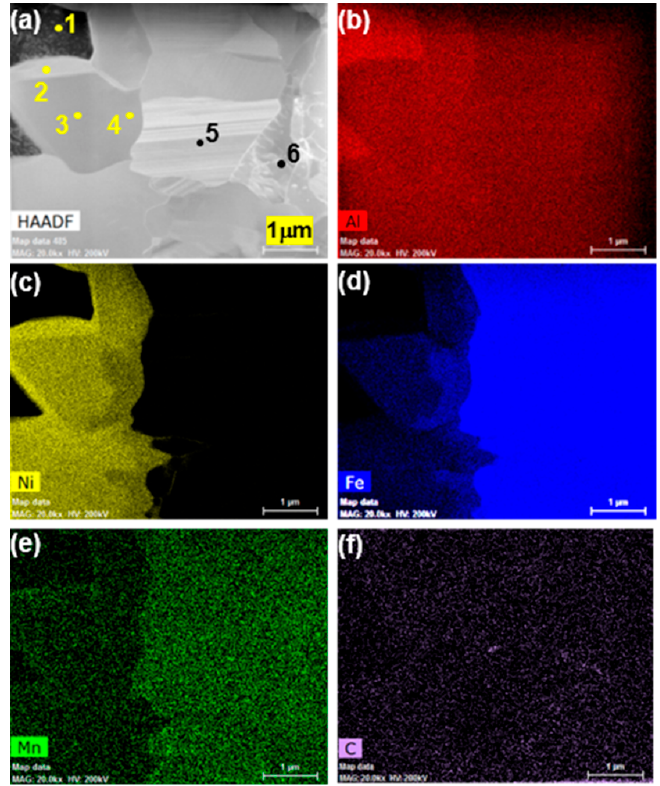
Figure 6a shows the TEM structure (high-angle annular dark-field (HAADF) image), and Figure 6b–f shows the concentration distribution of Al and Ni in the coating alloy and the distribution of Fe, Mn, and C in the steel, obtained by EDS analysis. Figure 7 shows the diffraction pattern and the analytical result of each phase indicated by 1–6 in Figure 6a, where ZA is the zone axis. Table 2 lists the composition of each phase determined by EDS. From the analysis results of the EDS composition and the diffraction pattern, phase 1 was found to consist of only Al. Phases 2, 3, and 4, which contained Al and Ni and a small amount of Fe, were all identified as the Al 9 FeNi (T) phase with a monoclinic crystal structure (space group: P 21/ c ). As shown in Figure 6a–d, Al 9 FeNi was characterized by the difference between the concentrations of Ni and Fe present in the crystal grains. On the other hand, from the diffraction pattern and the EDS analysis results shown in (e) and